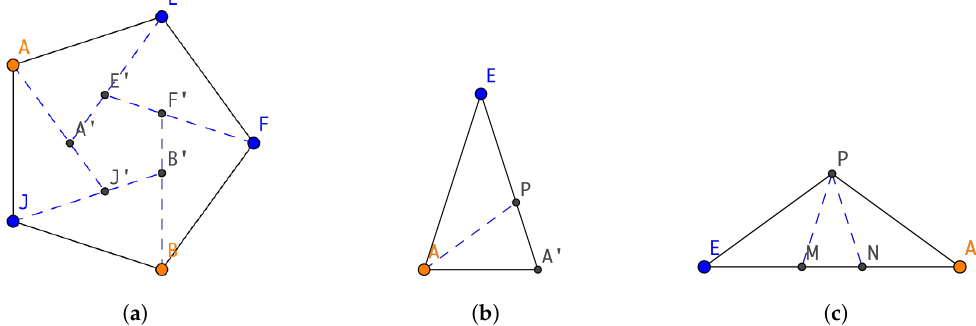
Figure 3. Recursive partitions of a pentagon. ( a ) Point insertion in a pentagon and partitions; ( b ) point insertion in an acute isosceles triangle and partitions; ( c ) point insertion in an obtuse isosceles triangle and